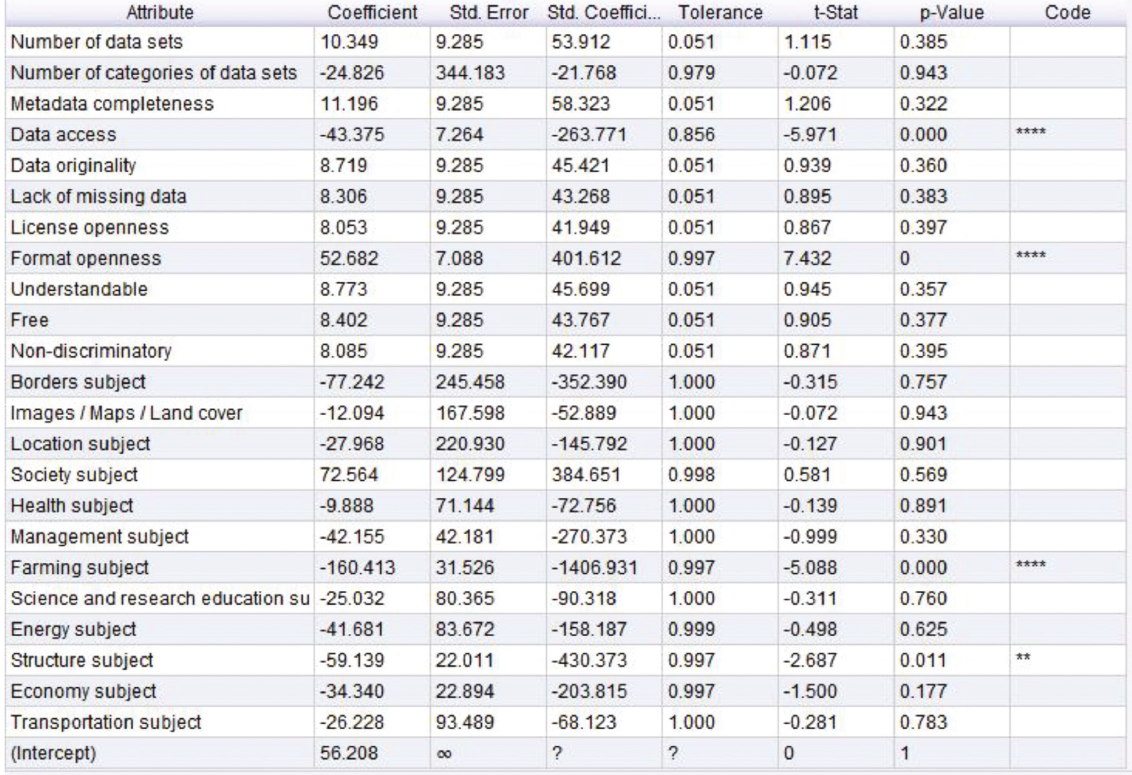
Figure 8: Regression coefficients based on each